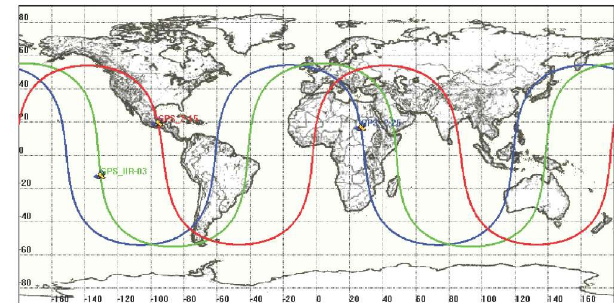
Table 3. Default host